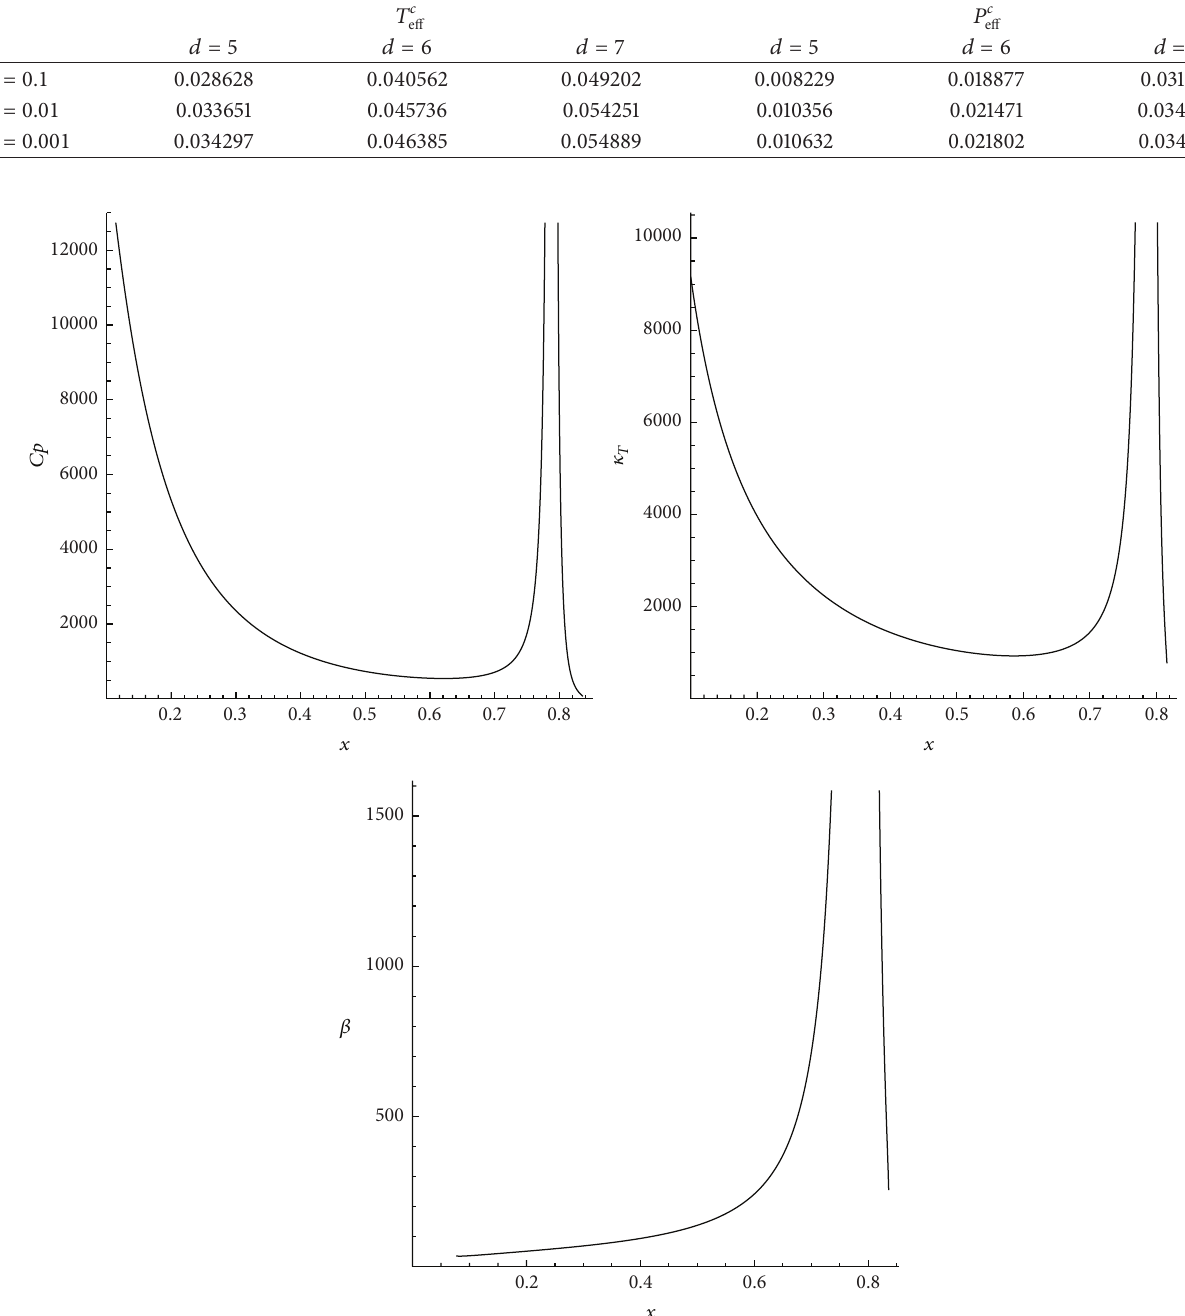
Figure 2: 𝐶 𝑃 - 𝑥 , 𝜅 𝑇 - 𝑥 and 𝛽 - 𝑥 curves for charged GB-dS black hole with 𝑄 = 1 , 𝑑 = 5 , and ̃𝛼 = 0.1